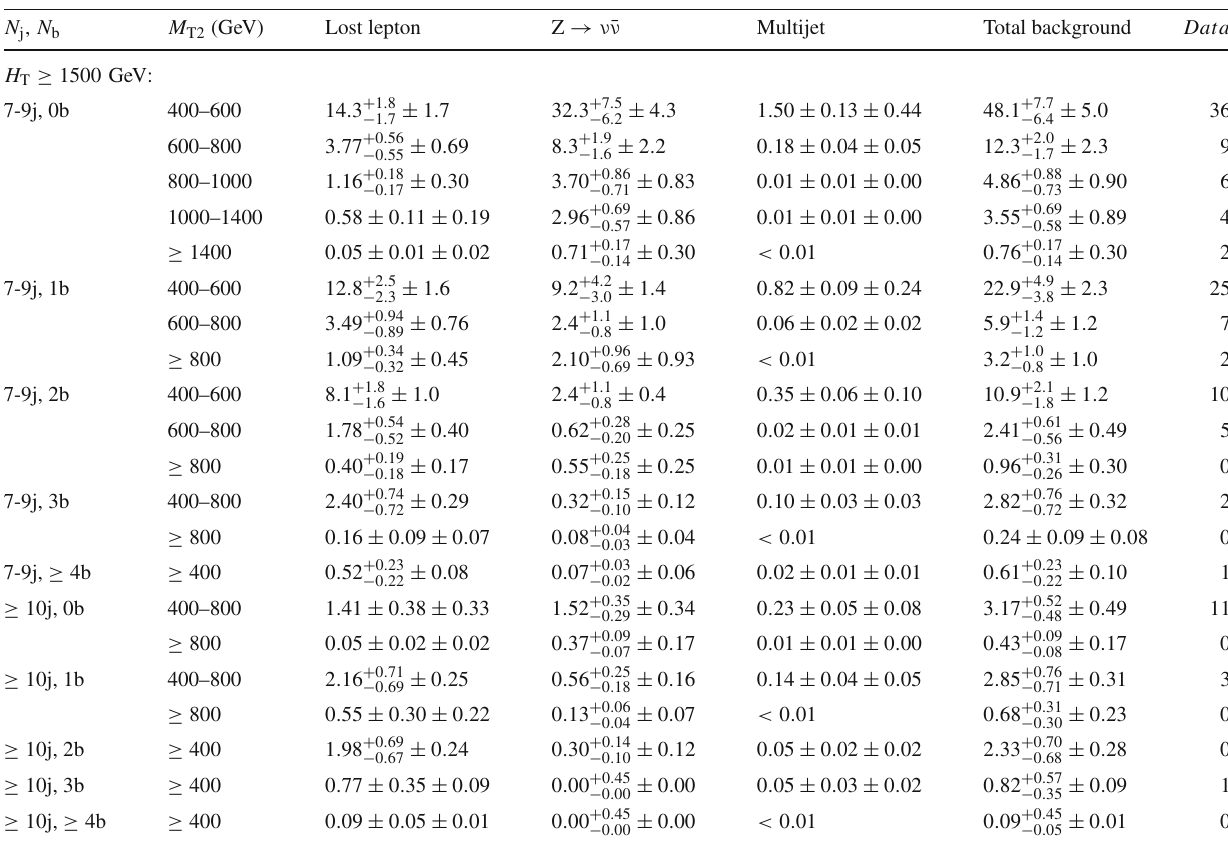
Table 23 Predictions and observations for the 21 search regions with H T ≥ 1500 GeV, and 7 ≤ N j ≤ 9, or N j ≥ 10. For each of the back- ground predictions, the first uncertainty listed is statistical (from the